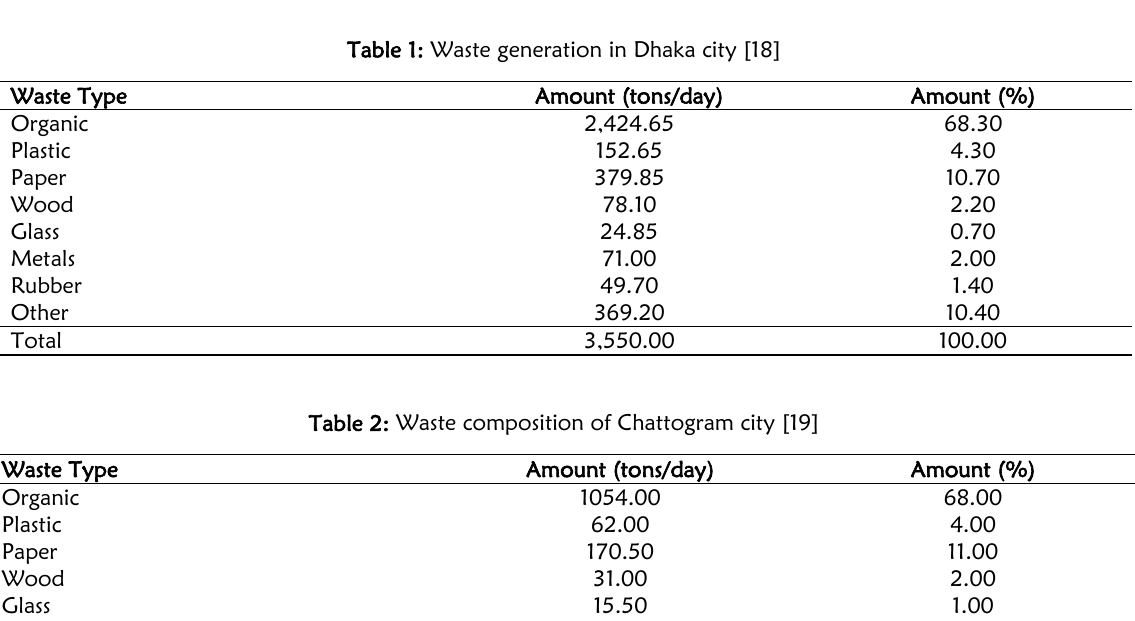
Figure 5: Plasma waste processing plant [17].